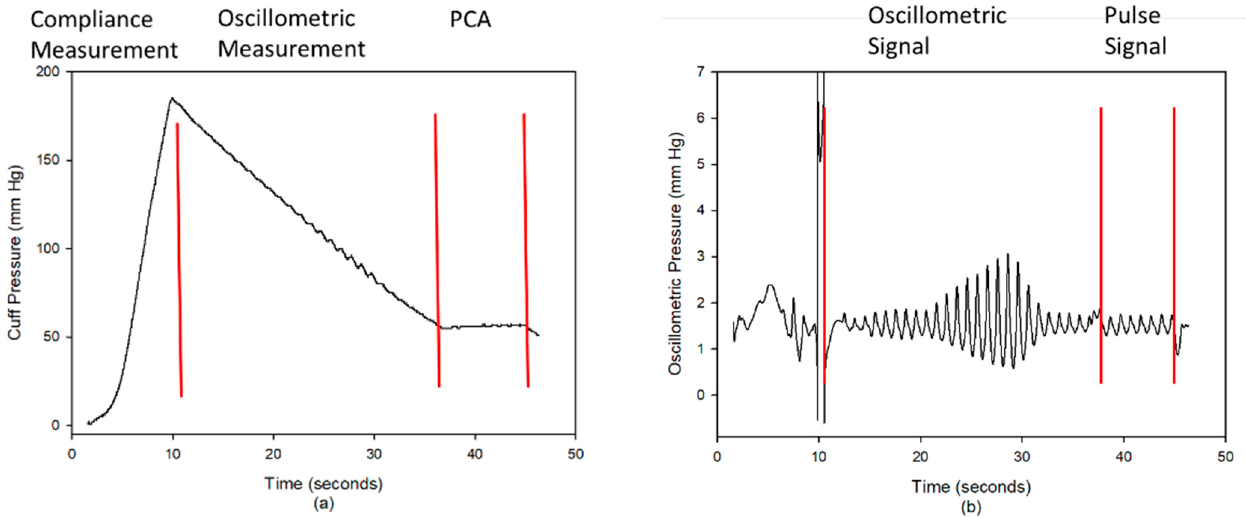
Figure 2. ( a ) The cuff pressure has three phases, inflating duration (compliance measurement), de- flating duration (oscillometric measurement), and holding duration (pulse contour analysis, PCA). ( b ) The oscillometric signal was used to measure the blood pressure, and the pulse signal was used to measure the SV.